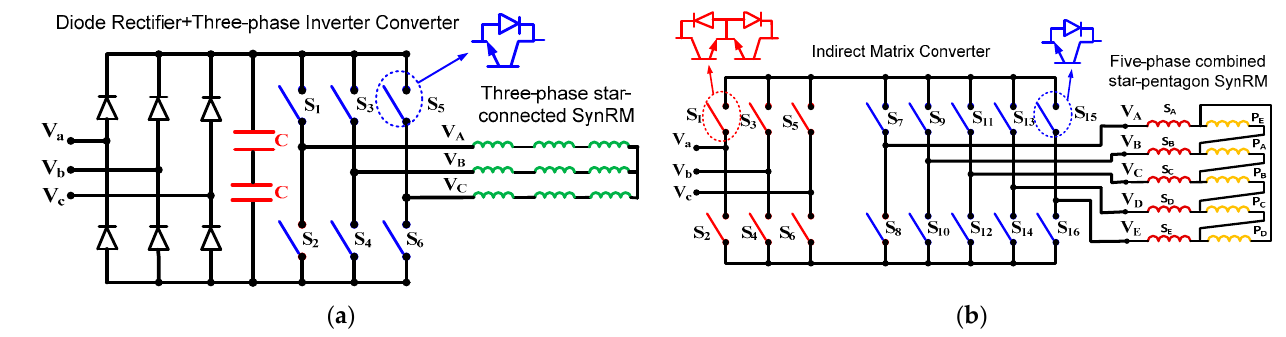
Figure 1. ( a ) The conventional drive system, ( b ) the proposed drive system.